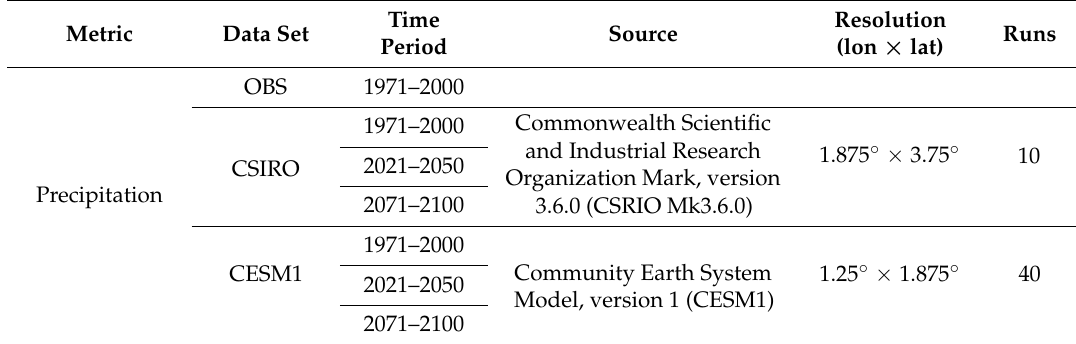
Table 1. Basic information of the observed and model simulated precipitation used in this study. Metric Data SetTime Period